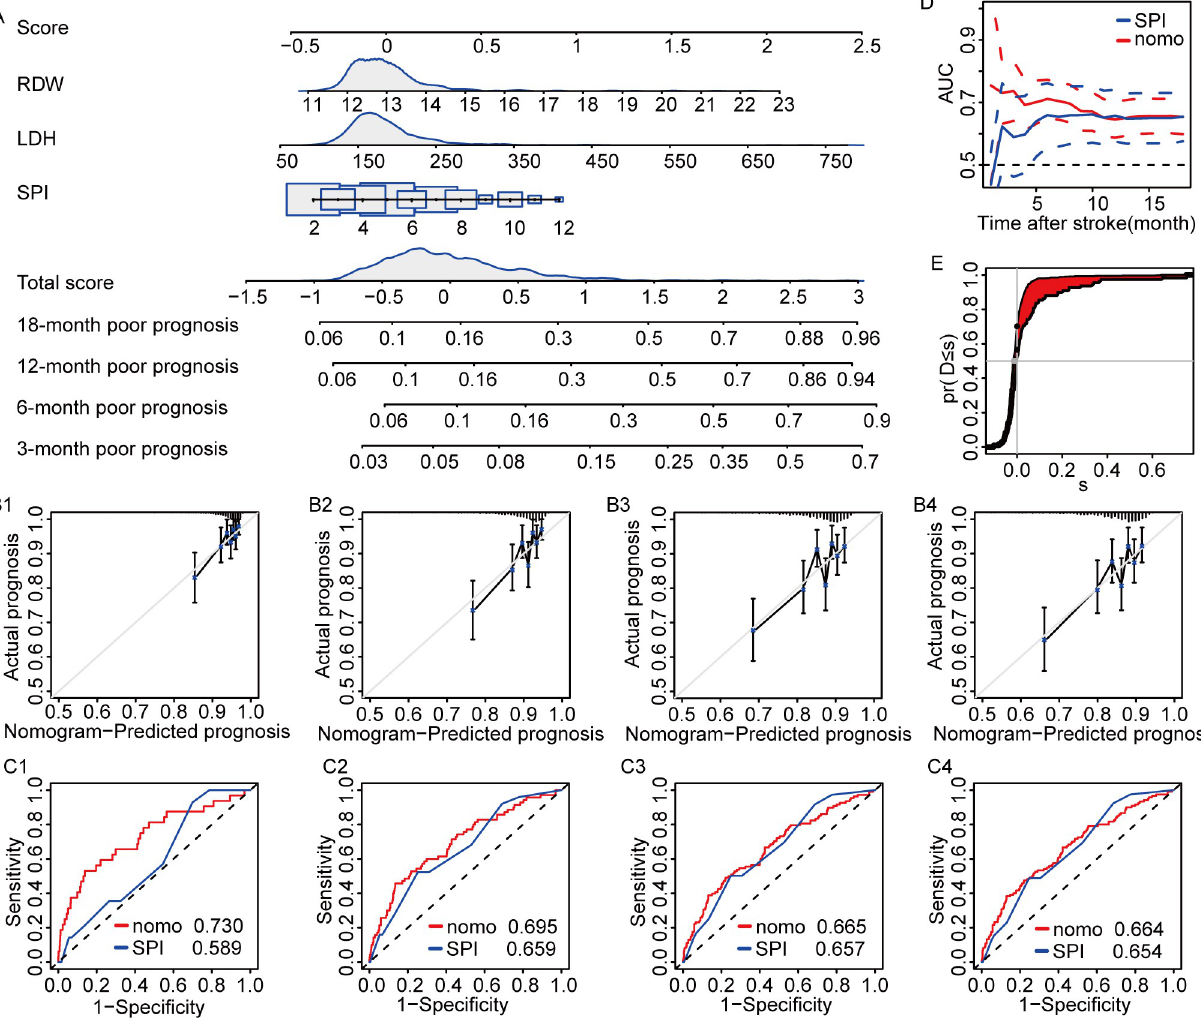
Fig 6. The models for predicting the prognosis in patients with AIS. A. Nomogram for the prognosis in patients with AIS; B. The calibration curves based on nomogram prediction and actual observation at 3-month(B1), 6-month(B2), 12-month(B3), 18-month(B4); C. Time-dependent ROC curves to evaluate the accuracy of the nomogram at 3-month(C1), 6-month(C2), 12-month(C3), 18-month(C4); D. Time-dependent ROC curves to evaluate the accuracy of the nomogram. E. NRI and IDI to evaluate the accuracy between the nomogram and the SPI